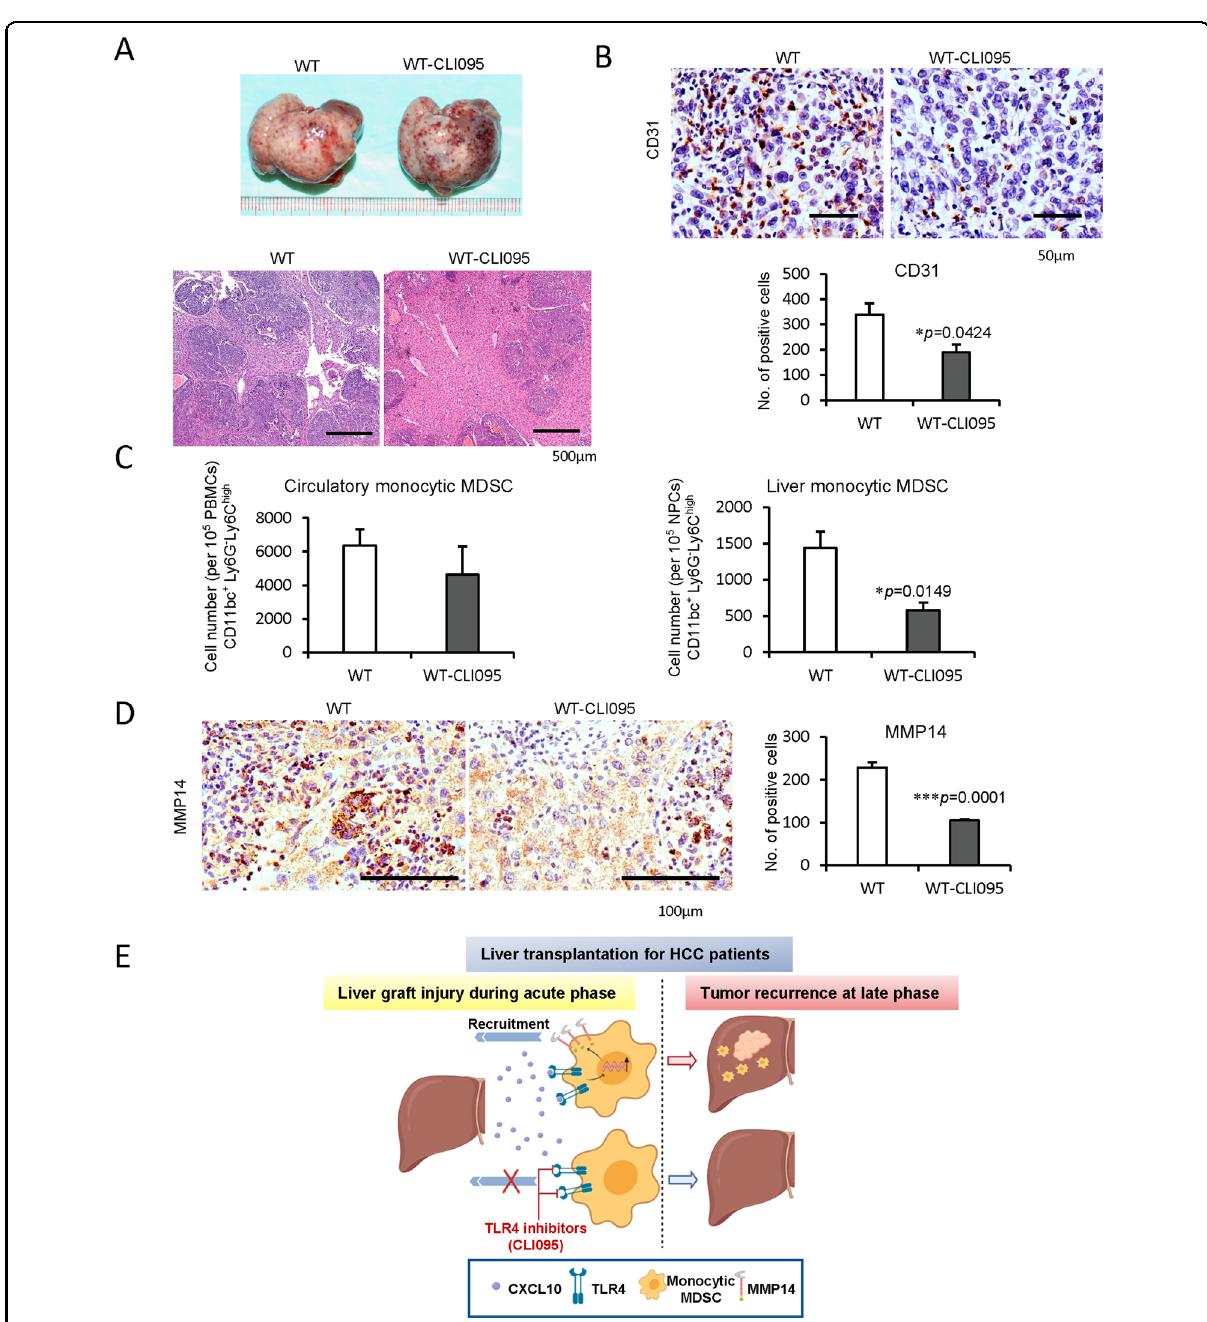
Fig. 7 Decrease of cancer recurrence, monocytic MDSCs, and MMP14 by TLR4 inhibition in mouse liver IRH with tumor recurrence model. A Reduced tumor progression by the treatment of TLR4 inhibitors (CLI095) compared to no treatment wild type mice; scale bars: 500 μ m. B The obvious decline of in fi ltrated CD31 positive cells in tumor tissue by TLR4 inhibition; scale bars: 50 μ m. C Decreased liver monocytic MDSCs by TLR4 inhibition. D Less in fi ltrated MMP14 in the mice with the treatment of TLR4 inhibitors; scale bars: 100 μ m. E Research summary: monocytic MDSCs were mobilized and recruited to liver graft through CXCL10/TLR4/MMP14 signaling during acute phase injury, and to promote HCC recurrence after transplantation. N = 5/group; error bars indicate standard error of mean; *p < 0.05, ** p < 0.01, *** p < 0.001. MDSC myeloid-derived suppressor cell, MMP14 matrix metallopeptidase 14, IRH ischemia/reperfusion plus major hepatectomy, WT wild